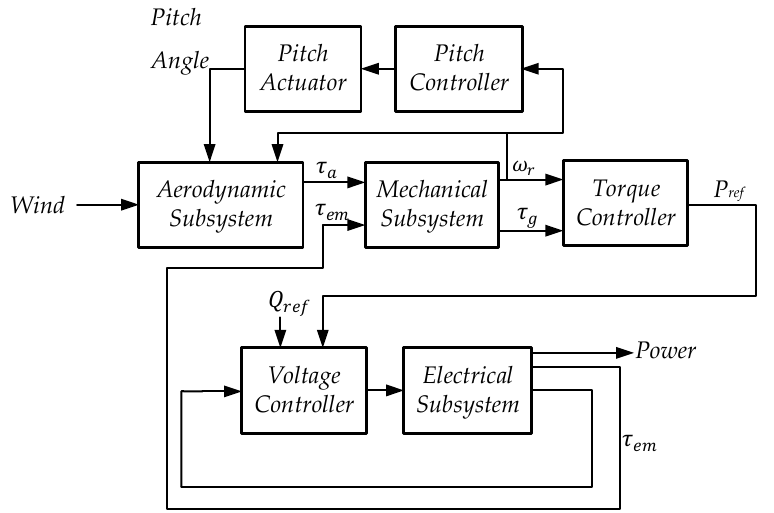
Figure 3. Wind Turbine Block